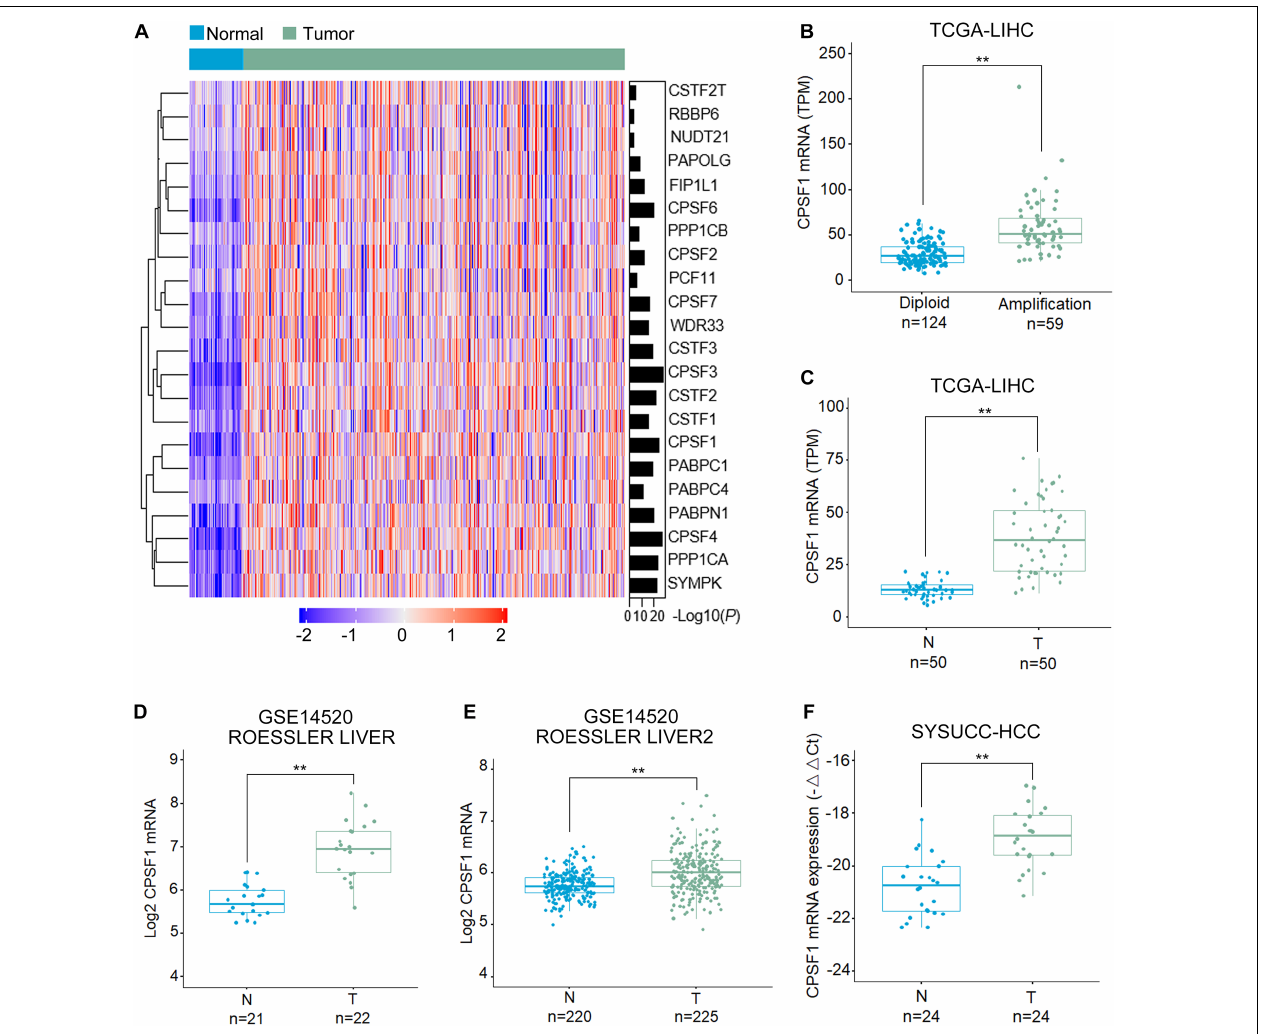
FIGURE 1 | CPSF1 expression is increased in HCC tissues. (A) Heatmap comparison of the mRNA level of genes involved in the CPA complex in TCGA LIHC (liver hepatocellular carcinoma) and normal liver samples. (B) Boxplots illustrating the correlation between genome amplification and mRNA level of CPSF1. Boxplots comparing the mRNA expression of CPSF1 in tumor (T) and non-tumor (N) tissue samples in the (C) TCGA LIHC dataset, (D) ROESSLER LIVER, and (E) ROESSLER LIVER2 datasets (GSE14520). (F) CPSF1 mRNA levels were validated in 24 paired HCC samples using Sun Yat-sen University Cancer Center (SYSUCC) samples. 18S RNA was used to normalize the relative fold changes. Statistical data were assessed using Student t -test and presented as the mean ± SD. ** P <